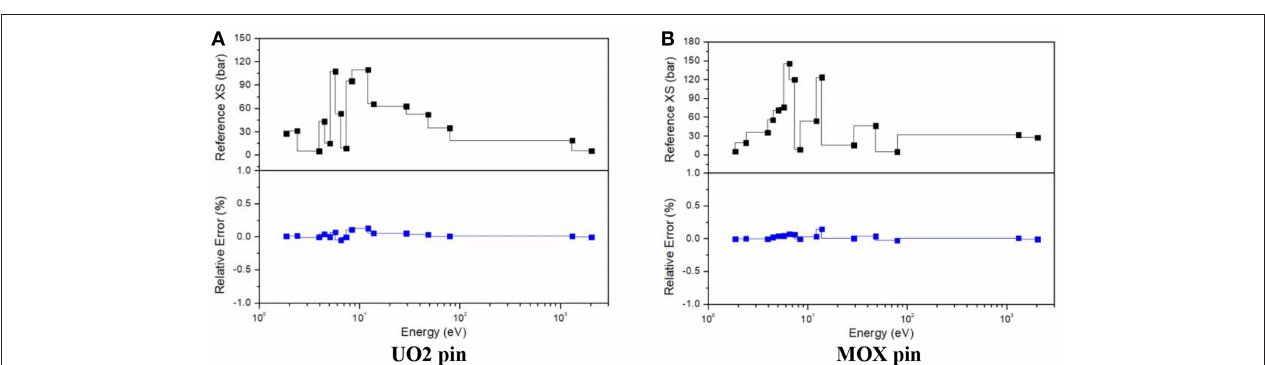
FIGURE 6 | Errors of U-235 absorption cross section of single cell. (A) UO2 pin, (B) MOX pin.